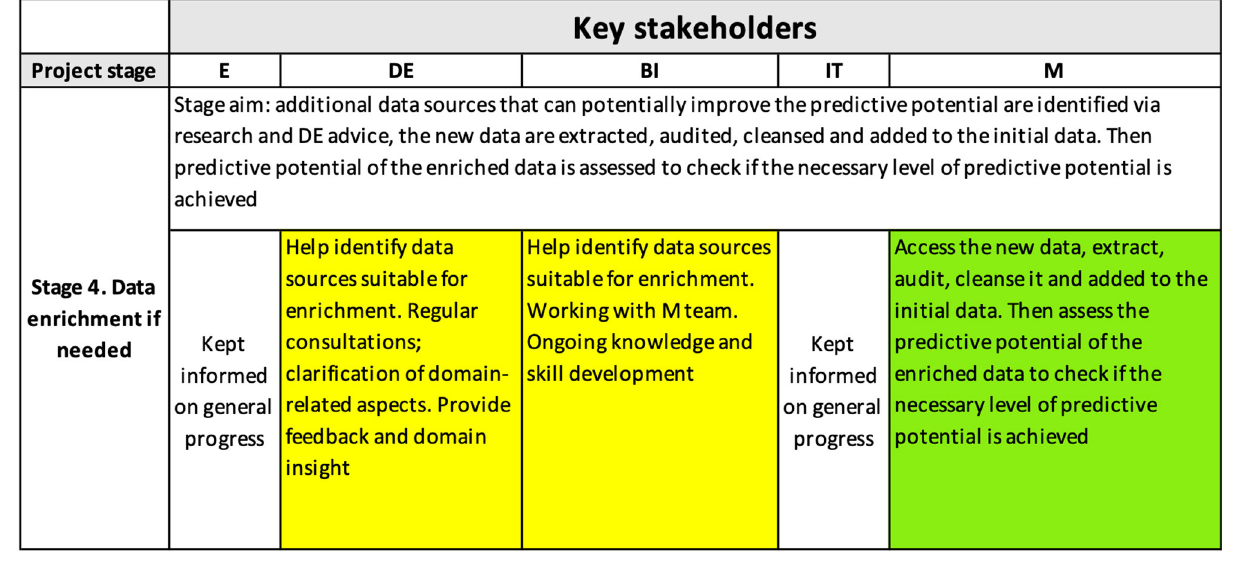
FIGURE 6 | Interpretability matrix content for Stage 4.